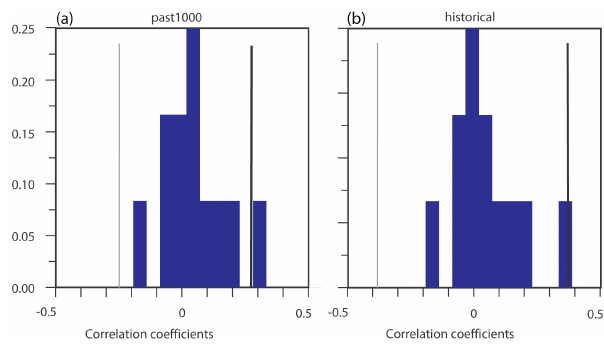
Figure 7. Frequency histogram in bins of 0.05 width showing the distribution of across-ensemble correlations between the up- welling indices simulated in each upwelling region for the ensem- bles past1000 (a) and historical (b) of the MPI-ESM, after low-pass filtering with a 30-year (past1000 simulation) and a 10-year (his- torical simulation) filter, respectively. The vertical black lines indi- cate the 5–95% significance bounds taking the time filtering into account.